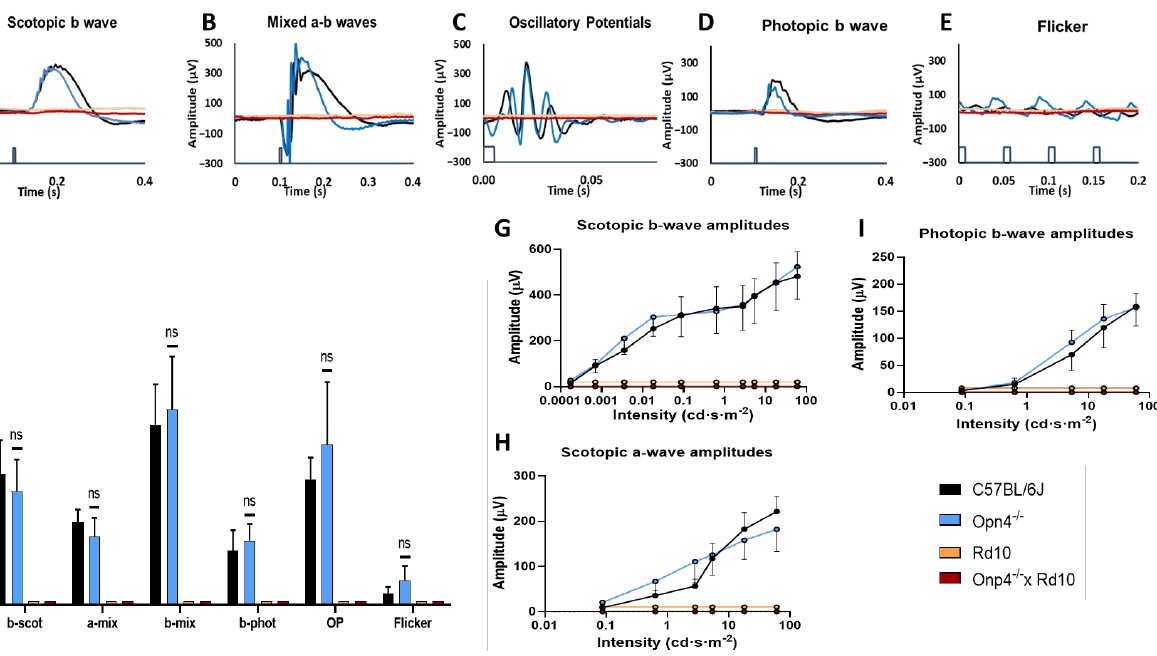
Figure 4. ERG waves in the models Rd10, Opn4 −/− × Rd10, C57BL/6J, and Opn4 −/− . Rod waves are shown ( A ), mix response ( B ), oscillatory potentials ( C ), cones response ( D ), flicker ( E ). Histogram of response amplitude for b scotopic waves, a mixed, b mixed, b photopic, oscillatory potentials, and flicker ( F ), and the illumination intensity – amplitude response curves for scotopic b waves ( G ), b photopic ( I ), and a scotopic wave ( H ). The sample size was eight mice for all groups. While the Opn4 −/− animal model does not show significant differences compared to the control, the models that present photoreceptor degeneration (rd) were hardly able to evoke any type of electrophysiological response from the cellular elements of the retina ( p < 0.001). Data are presented as the mean ± SD. (ns, not significant).